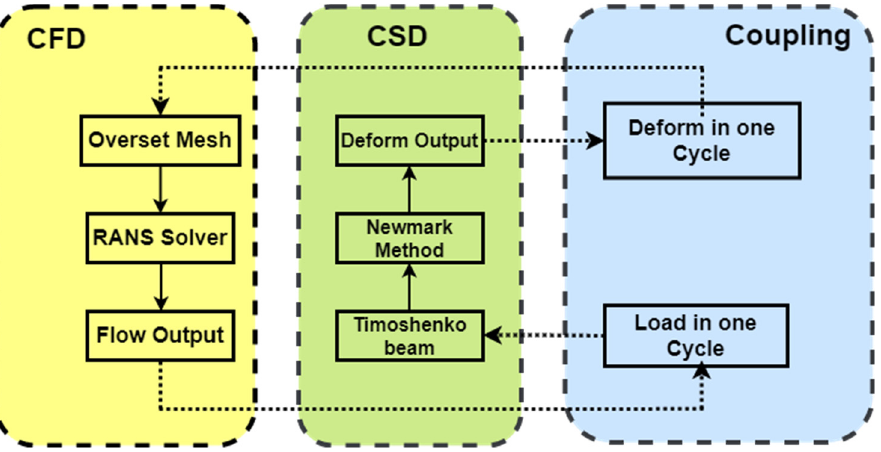
Figure 4. Flowchart of the CFD-CSD coupling.